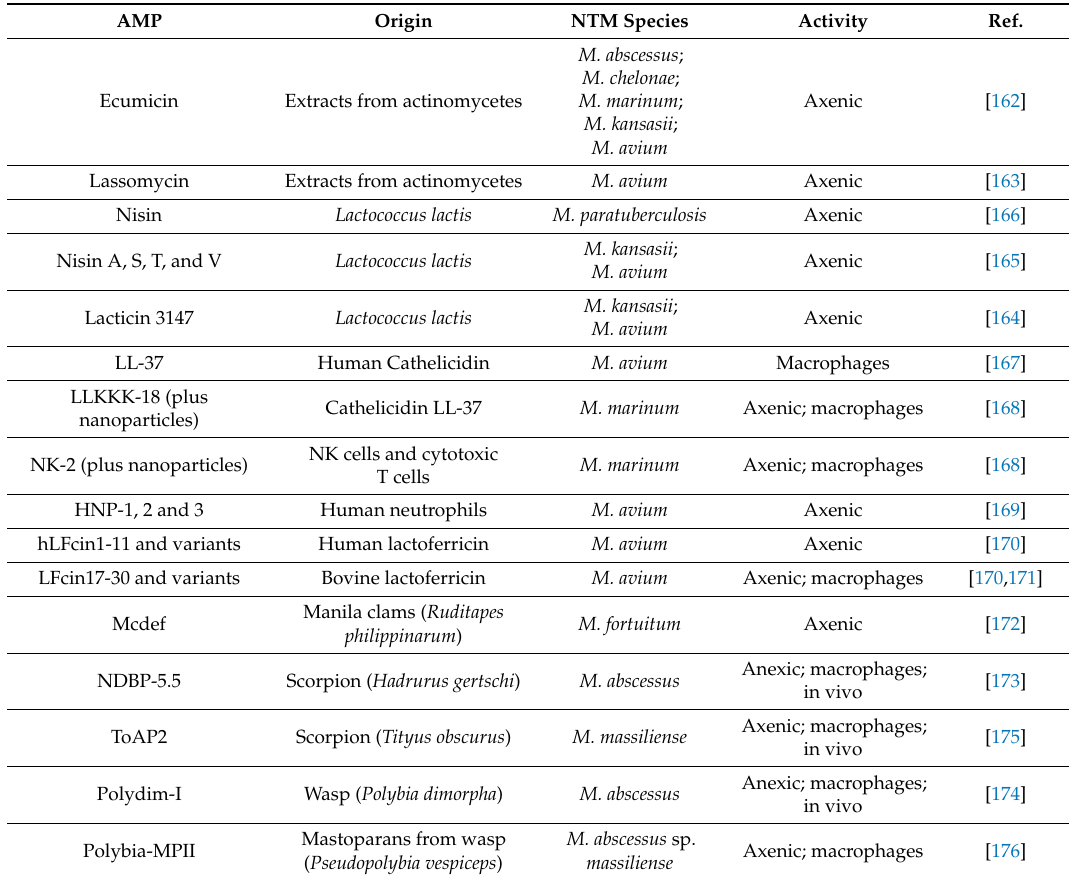
Table 3. Summary of AMP activity against